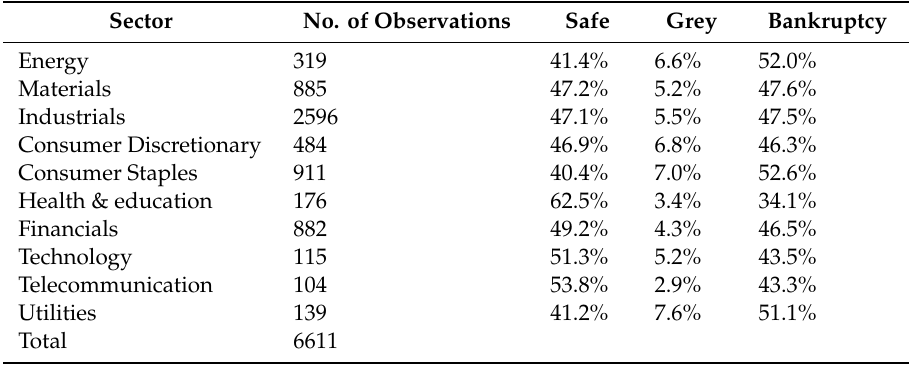
Table 9. Overall Distance to Default in all sectors for the full sample (2007–2017).